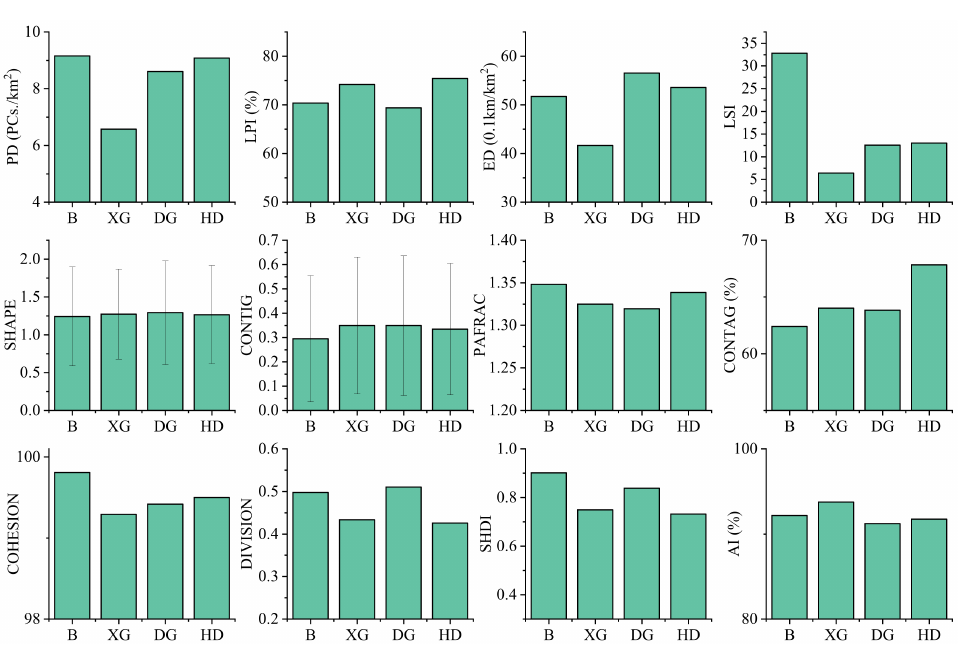
Figure 3. Distribution of the landscape pattern indices in the Baoan Lake basin and its sub-basins. In this figure, each index is patch density (PD), largest patch index (LPI), edge density (ED), landscape shape index (LSI), shape index (SHAPE), contiguity index (CONTIG), perimeter-area fractal dimen- sion (PAFRAC), contagion (CONTAG), patch cohesion index (COHESION), landscape division index (DIVISION), Shannon’s diversity index (SHDI), and aggregation index (AI), respectively. B, XG, DG, and HD represent the Baoan Lake basin, Baoanxi Gang sub-basin, Baoandong Gang sub-basin, and Huandiqiao Gang sub-basin,